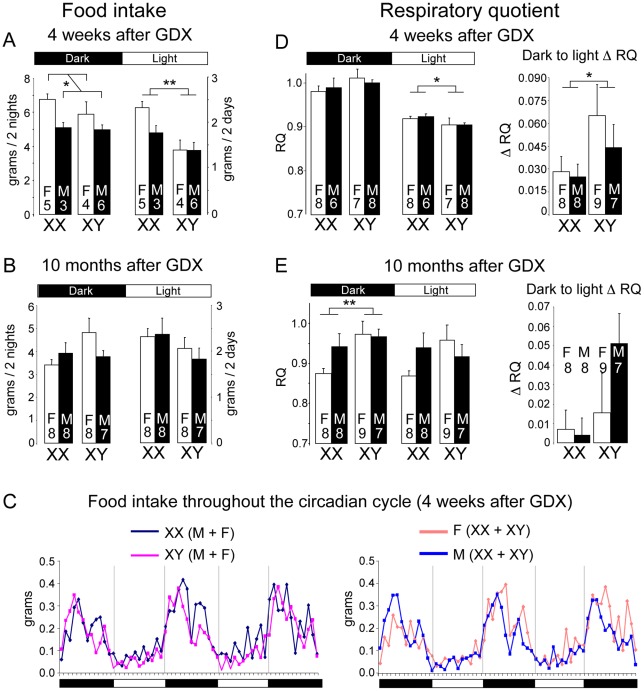
Altered food intake and RQ in XX versus XY mice.Mice were individually housed in metabolic cages to assess food take and energy balance parameters continually throughout the diurnal cycle. (A, B) Food intake determined at 4 weeks or 10 months following GDX. Values represent the mean ± SEM food intake summed over two dark or two light periods. Data shown represent raw values; normalization to body weight or to lean body mass gave the same outcome. (C) Food intake patterns throughout 3 nights and 2 days. At left, lines represent mean values for XX (n = 8) and XY (n = 10) mice; at right, lines represent mean values for gonadal females (n = 9) and gonadal males (n = 9). (D, E) Mean Respiratory Quotient (RQ) ± SEM for light and dark periods determined at 4 weeks or 10 months following GDX. At right, the change in RQ between dark and light periods (Δ RQ) is shown. *, p<0.05; **, p<0.01; ***, p<0.001; ‡, p<0.000001.